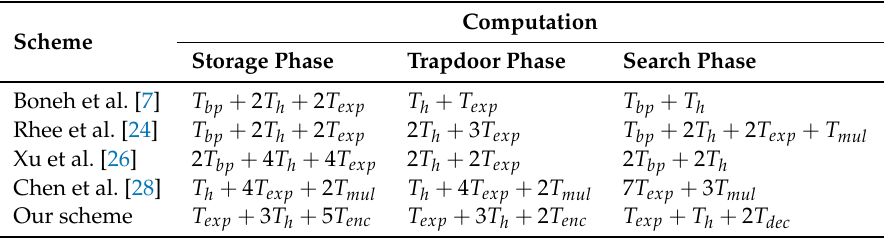
Table 3. Computation cost: a comprehensive